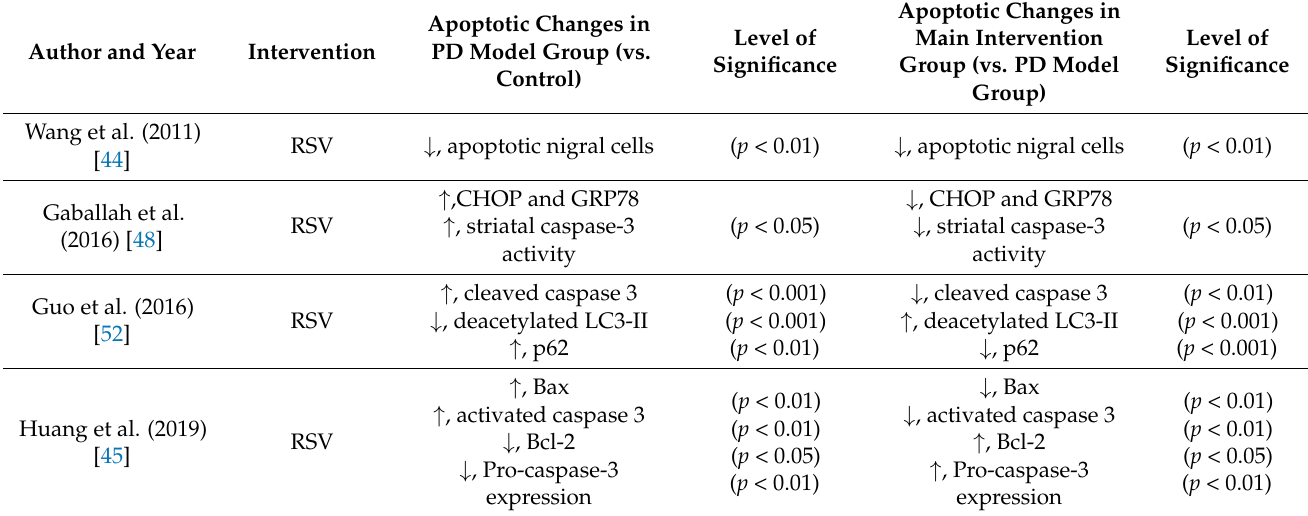
Table 7. Summary of biochemical and immunohistochemical analysis for markers of apoptosis PD model groups and